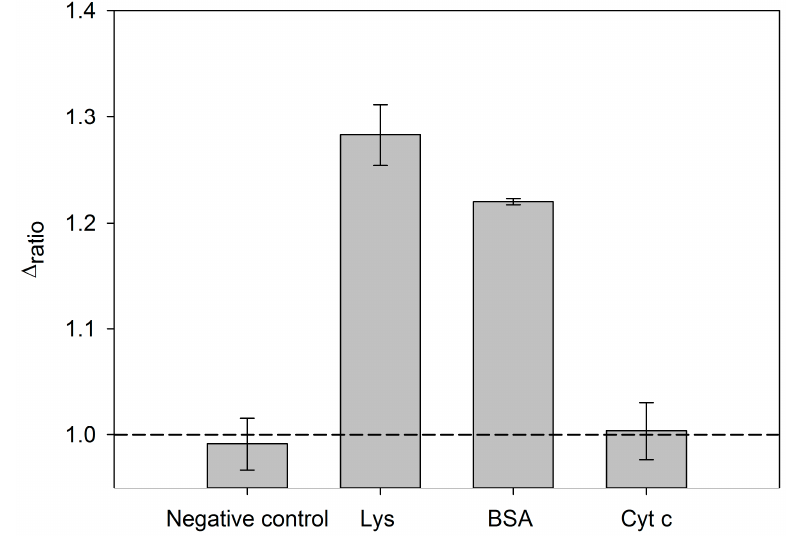
Figure 8. Specificity of AptLys to Lys, BSA, Cyt c at 0.5 µ M. Errors bars are obtained based on five independent measurements.